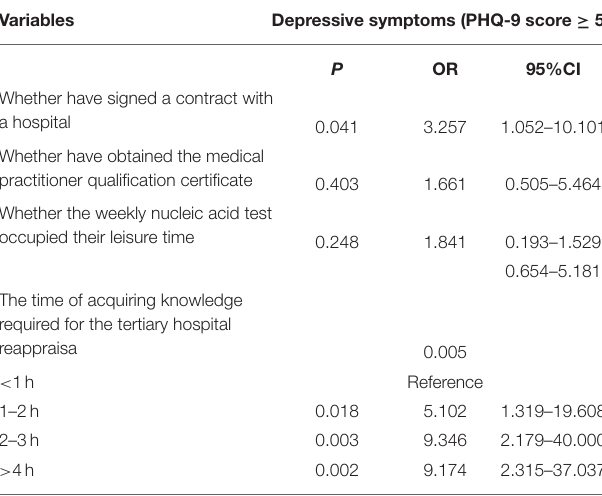
TABLE 2 | Multivariate logistic regression analysis of variables related to anxiety symptoms.